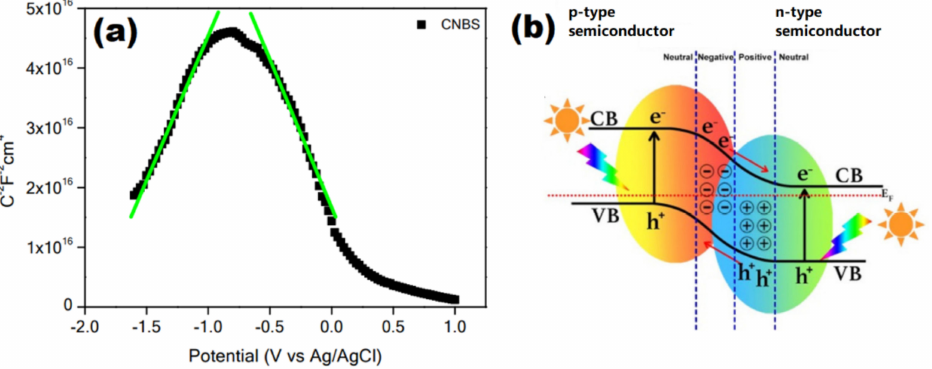
Figure 20. ( a ) The Mott–Schottky graph for S, B-GCN shows 2 slopes, and ( b ) the illustration of the p-n junction. (Reproduced with permission from Ref.